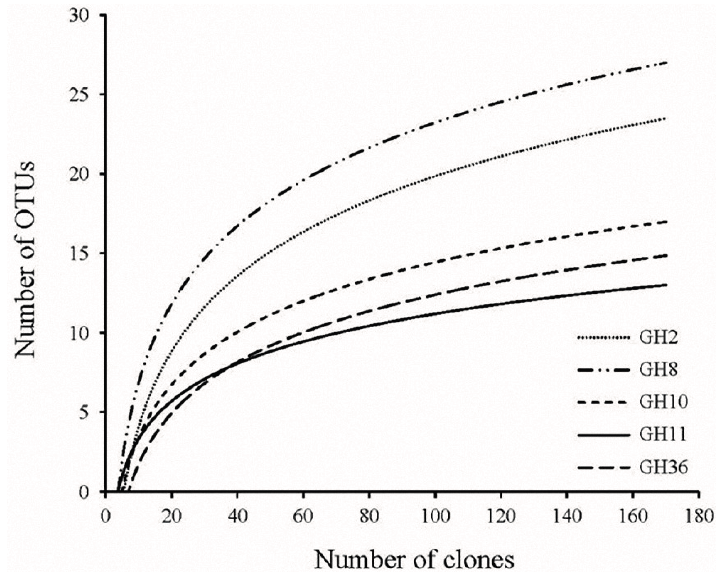
Figure 2. Rarefaction curves corresponding to the cellulase and hemicellulase genes from the hindgut of Holotrichia parallela larvae. Operational taxonomic units (OTUs) were defined at the 3% level of sequence divergence.